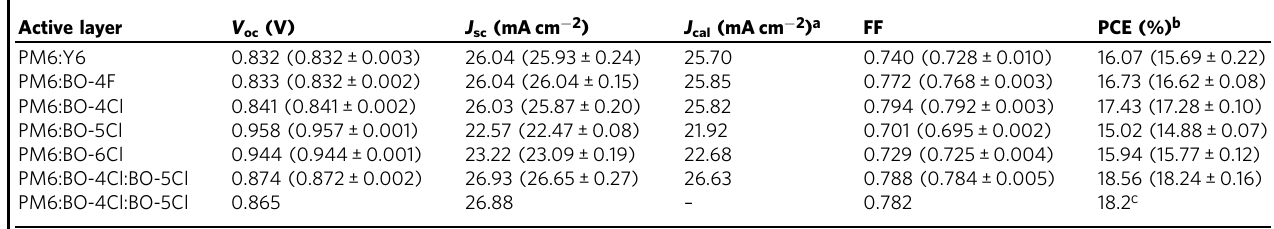
a Integrated current densities from EQE curves. b Average PCEs from 15 devices. c Certi fi ed by National Institute of Metrology (NIM),